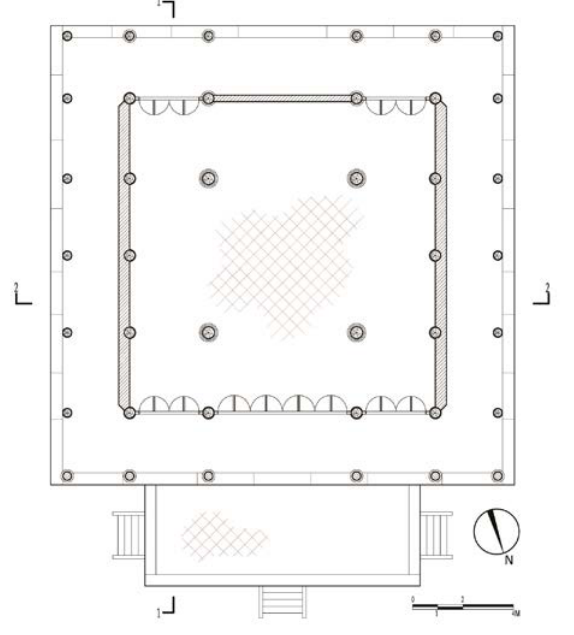
Figure 8. Plan of the Great Hall